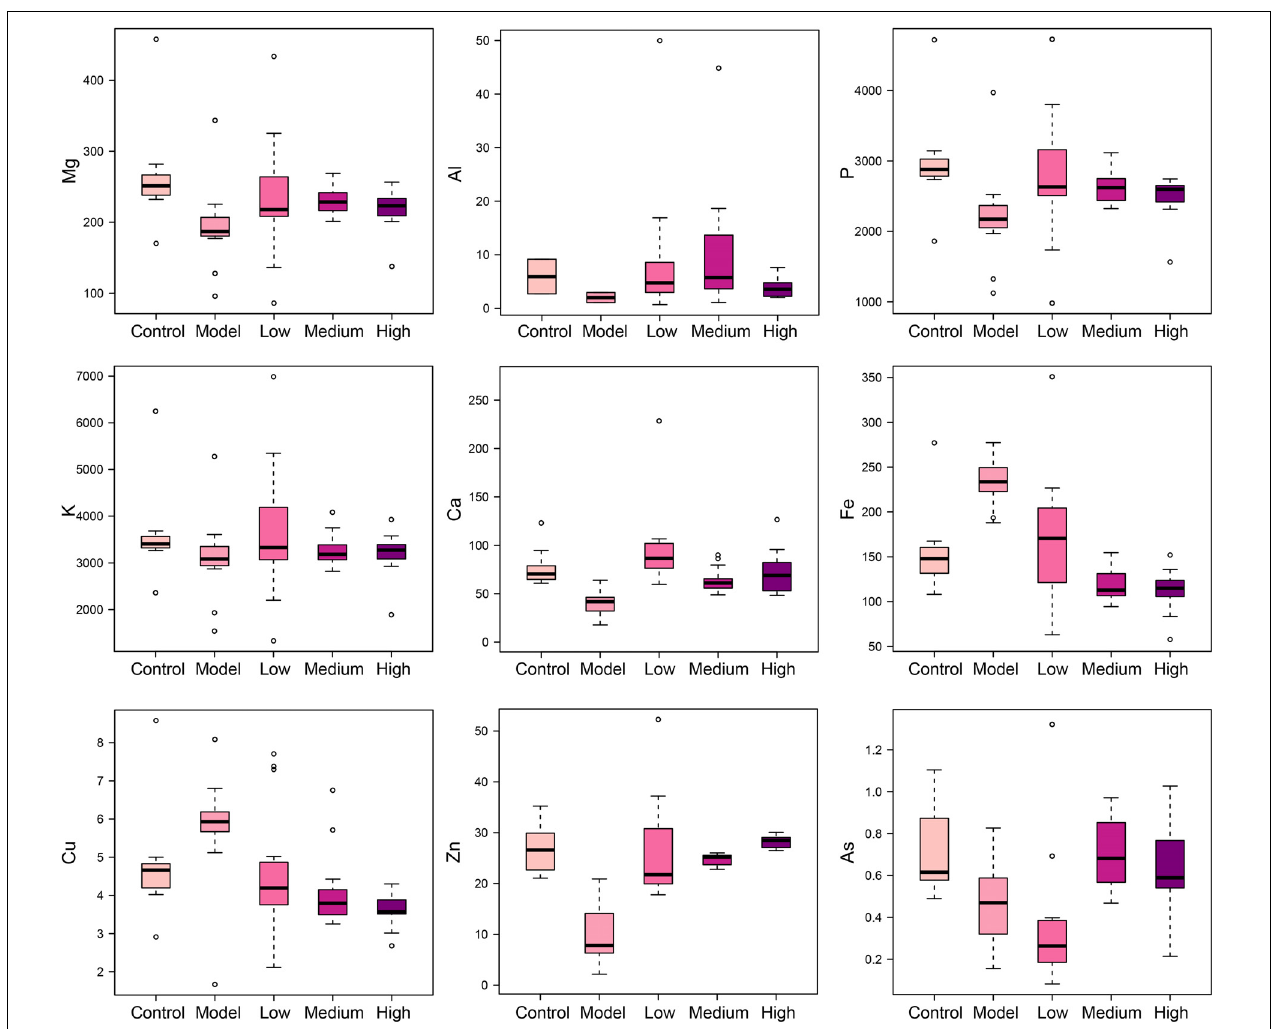
FIGURE 3 | Boxplots of elements levels in liver tissues of rats form control, model, and low, medium, and high dose of SWGNP treated groups. The boxes cover 25% quartile and 75% quartile of the data. The line in the box represents the median value. The extended whiskers show the extent of the rest of the data, and outliers are shown as open